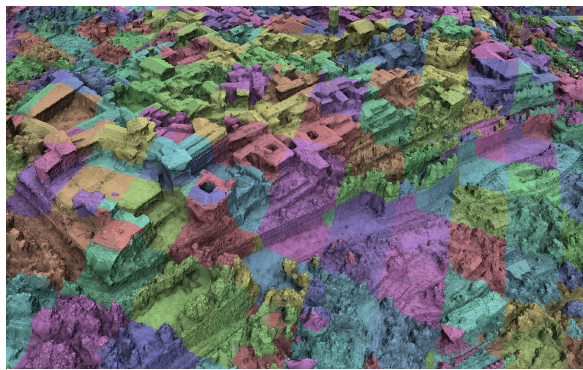
Figure 1. Target application: 3D surface reconstruction based on the proposed out-of-core Delaunay algorithm on 54 million points. Triangles of the resulting mesh are colored according to the tile that contains one of their